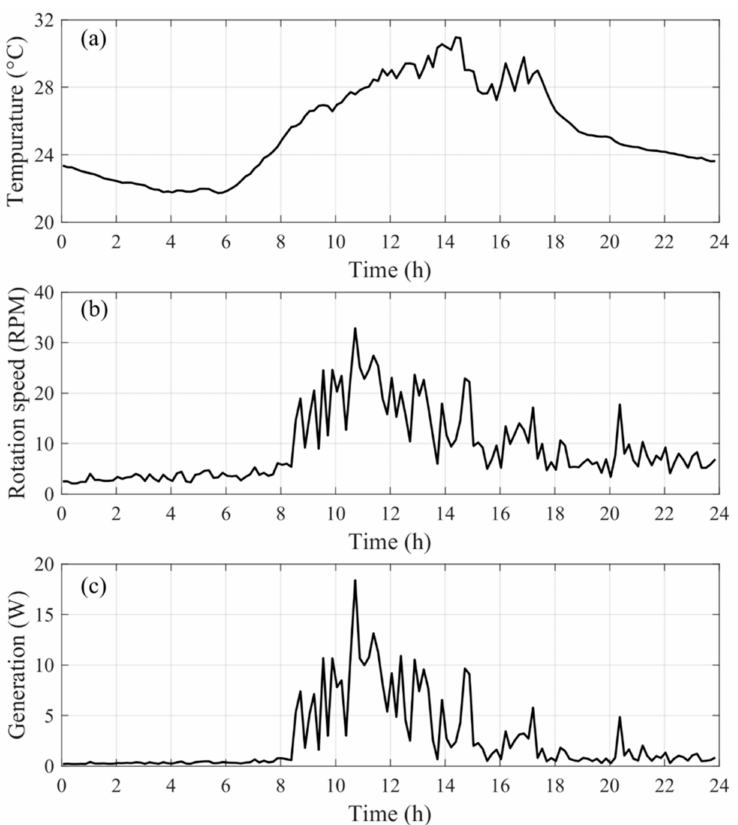
Figure 8. Typical monitoring data, recorded on on 28 August 2016: ( a ) wind turbine rotational speed; ( b ) temperature; ( c ) power generation distribution.